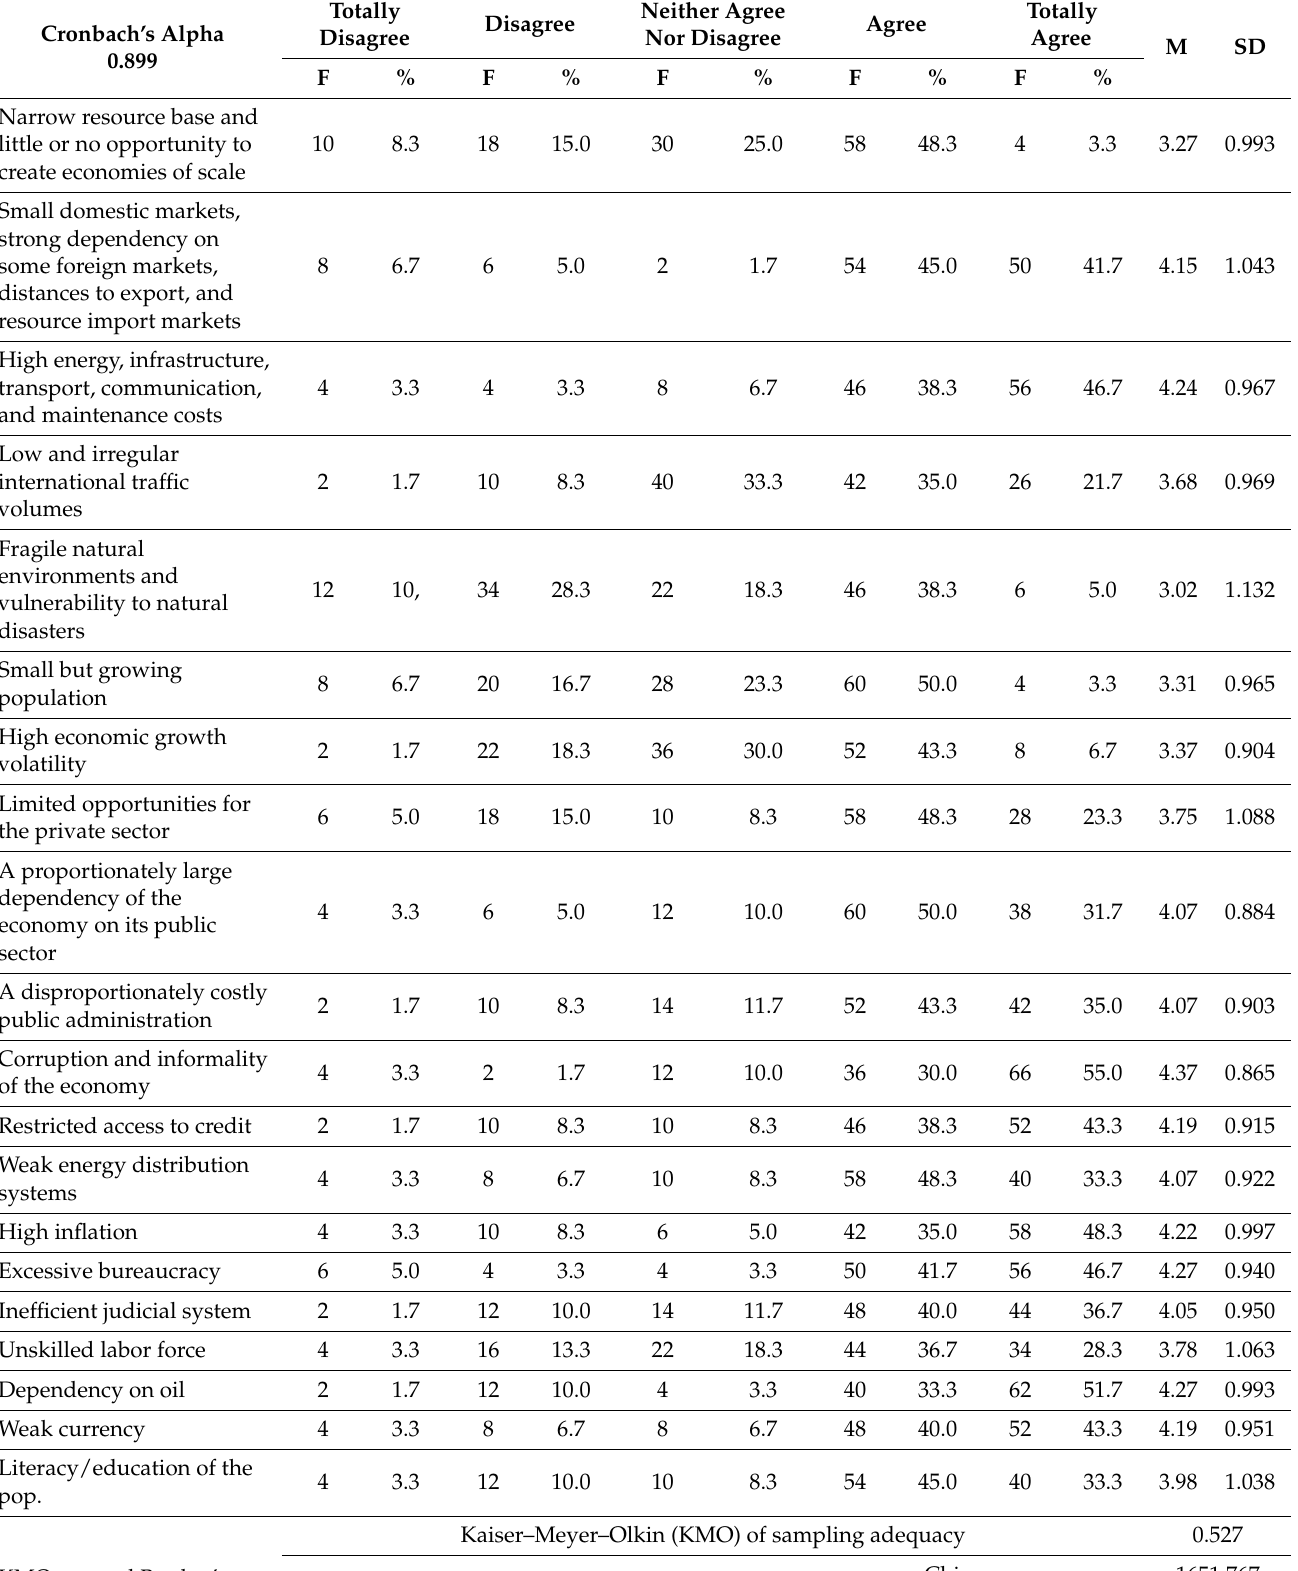
Table 5. Major economic, social, and environmental vulnerabilities in